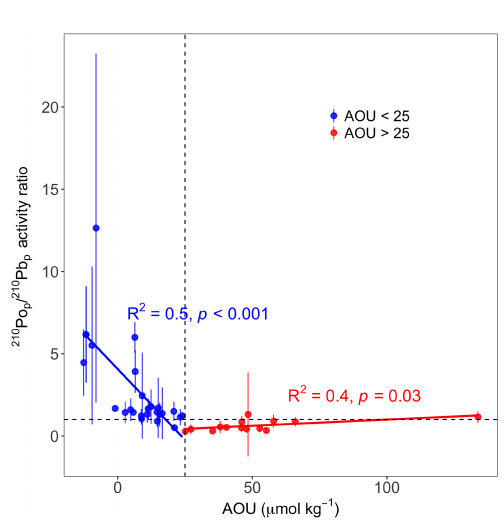
Figure 9. The relationship between AOU (µmolkg − 1 ) and total par- ticulate 210 Po / 210 Pb activity ratio ( 210 Po p / 210 Pb p ) from the up- per 200m in the Northern Hemisphere ( > 22 ◦ N) investigated by a linear regression model (red and blue lines). The 40 stations include data from previous studies – ARK-XXII/2 (77.38–87.83 ◦ N, n =